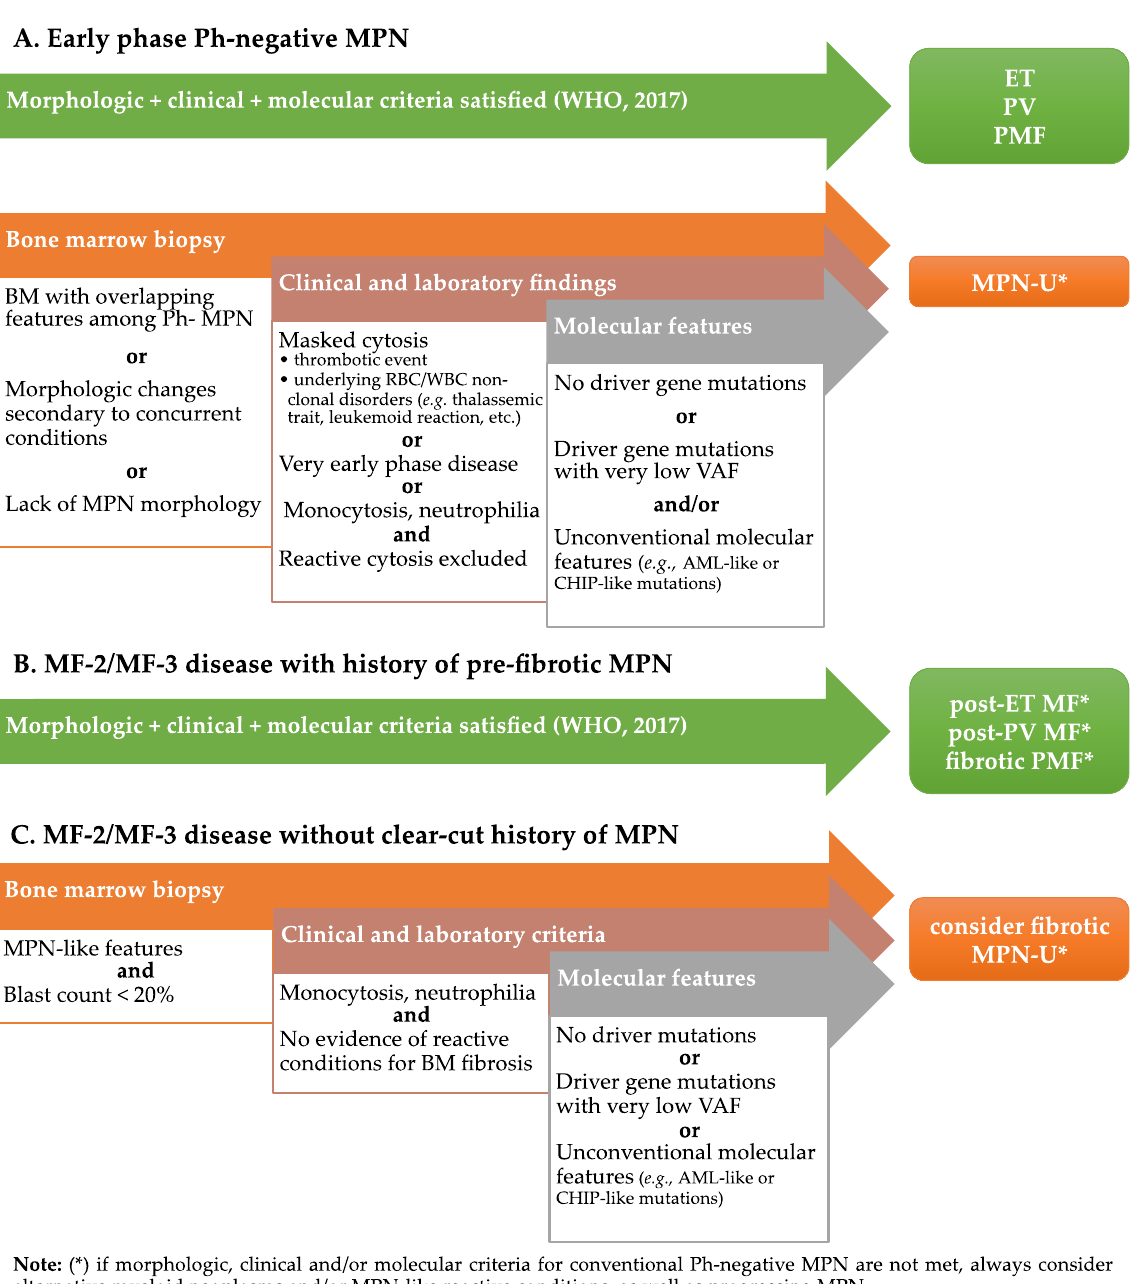
Figure 1. Diagnostic flow chart for patients with suspected MPN.